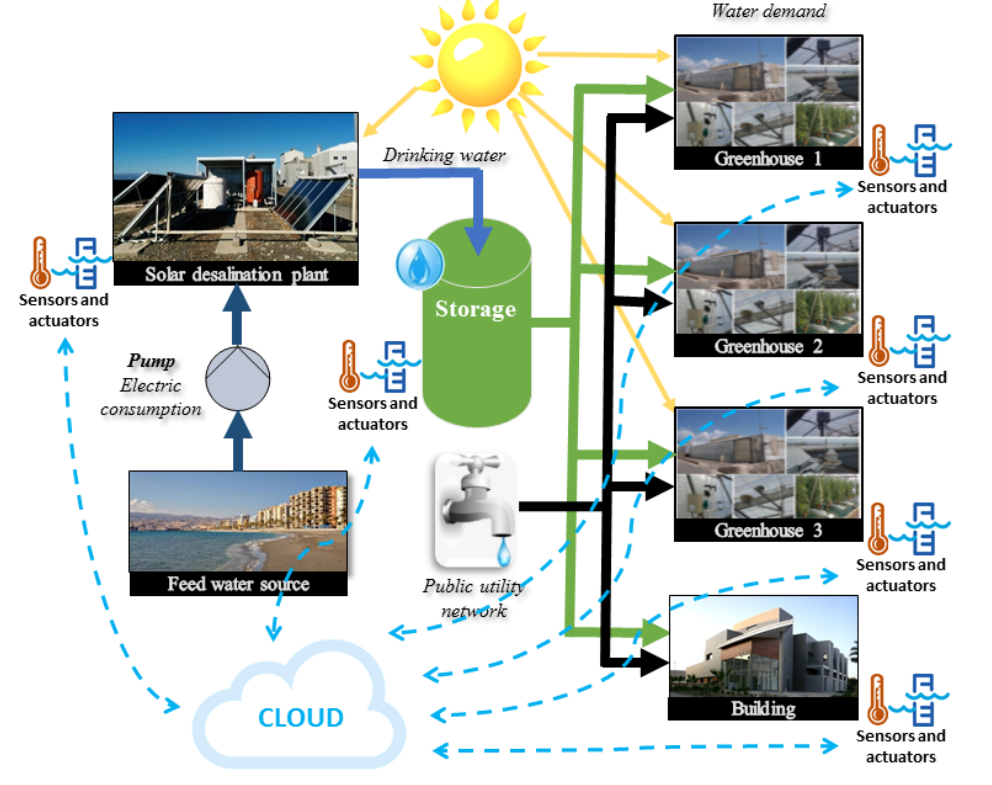
Figure 3. Layout of the case